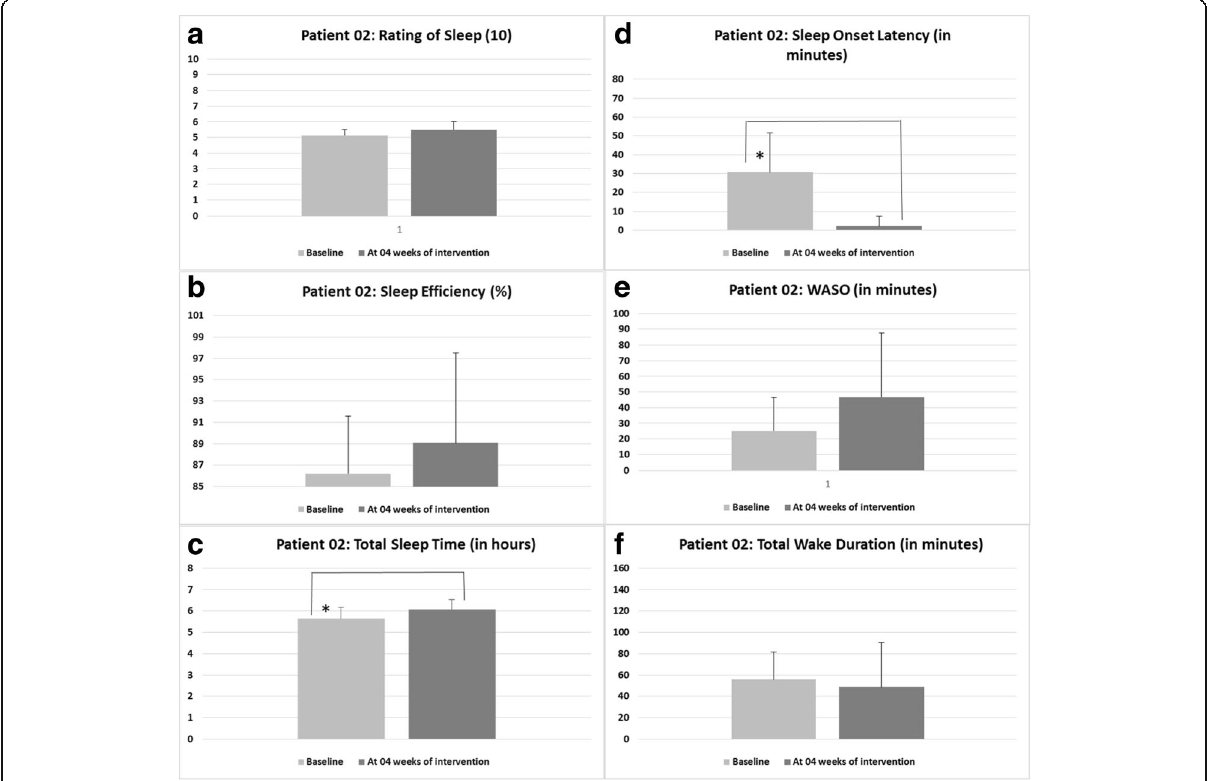
Fig. 4 a – f Sleep diary parameters of patient 02 showing various sleep wake parameters. * p < 0.05(using Wilcoxon Signed Rank